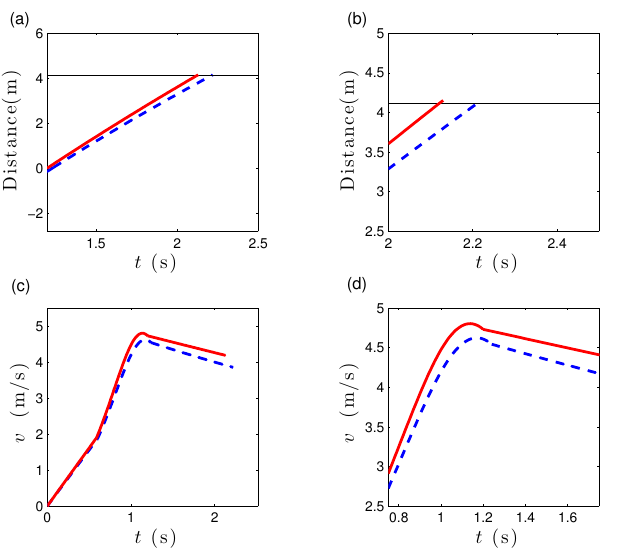
Figure 6. Displacement and velocity plots for two values of the car mass m = 0 . 05Kg (dashed), m = 0 . 35Kg (solid) and with the remaining parameters given in Table 2. The horizontal line in (a) and (b) represents the finish line. The car with highest mass is the first one to reach the end of the track.